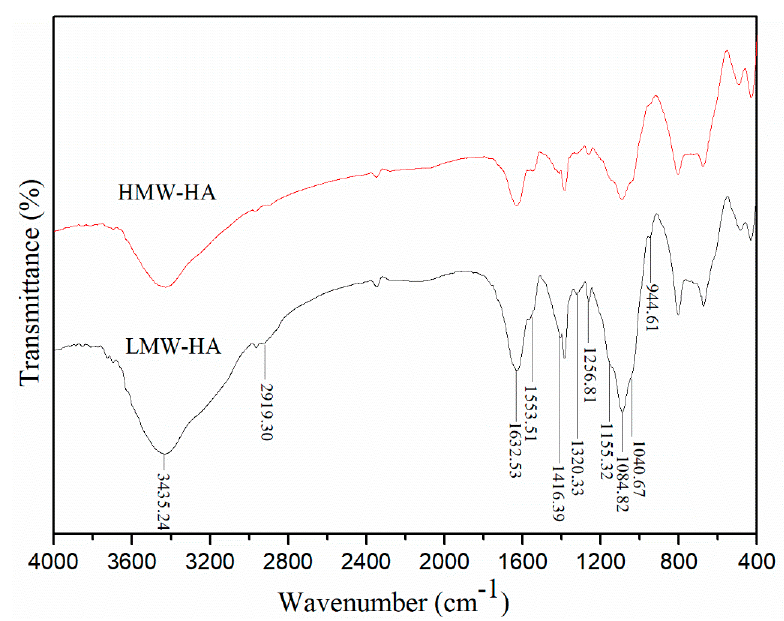
Figure 3. FTIR spectra of intact HA and LMW-HA degraded using the optimal method.